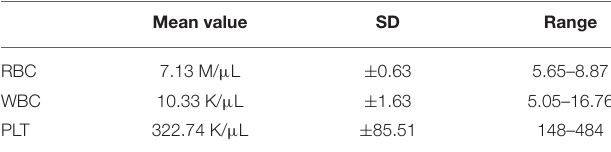
TABLE 3 | CBC mean values ( ± SD) of study population.